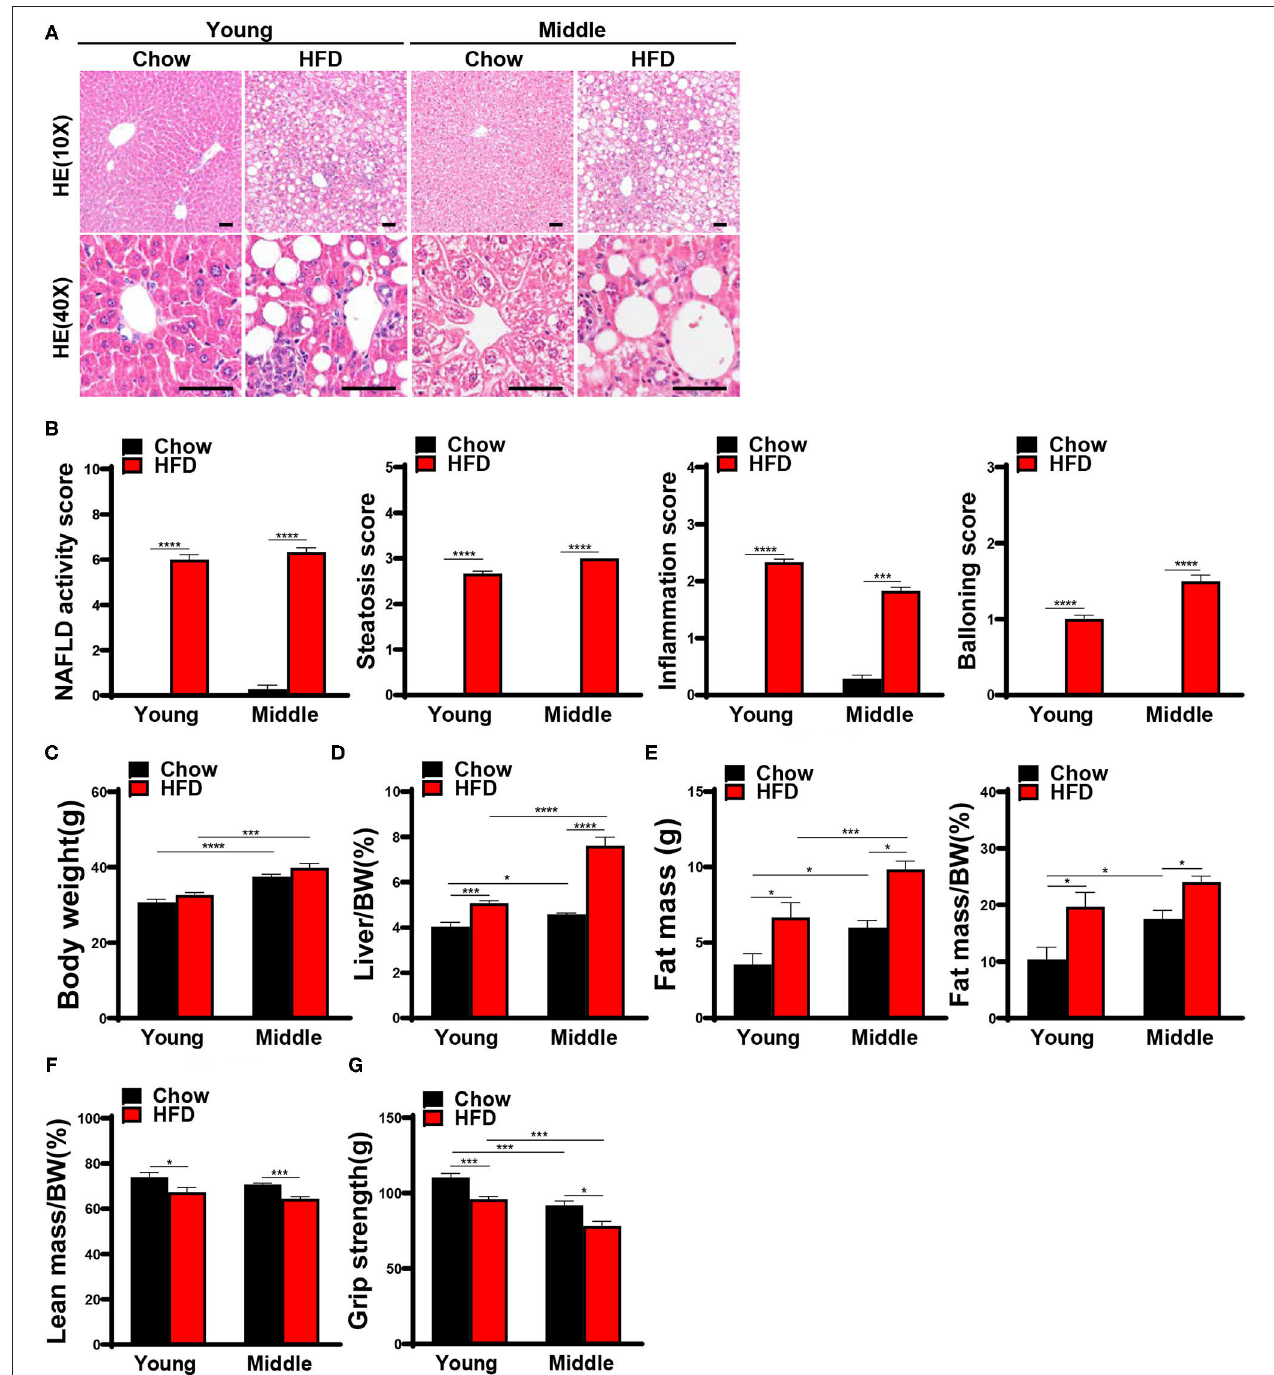
FIGURE 3 | Steatohepatitis and sarcopenic obesity were induced by 20 weeks HFD feeding. 8-week-old and 42-week-old male C57BL/6 mice were fed with a HFD for 20 weeks, mice were sacrificed after the assessment of body composition and muscle strength, and liver and muscle tissues were harvested. (A) Representative hematoxylin and eosin staining of liver sections in mice ( n = 6–9) are shown (scale bar, 50 µ m), (B) NAFLD activity score based on the NAS score algorithm was measured ( n = 6–9). (C) Body weights and (D) liver indexes of mice were weighed and calculated ( n = 6–9). (E) Fat mass, fat mass/ bodyweight (BW), (F) lean mass/BW were measured using NMR ( n = 5–8). (G) Grip strength was tested in vivo ( n = 6–10). The data are presented as the mean ± SEM, unpaired two-tailed Student’s t -test. * P < 0.05, *** P < 0.001, **** P < 0.0001.